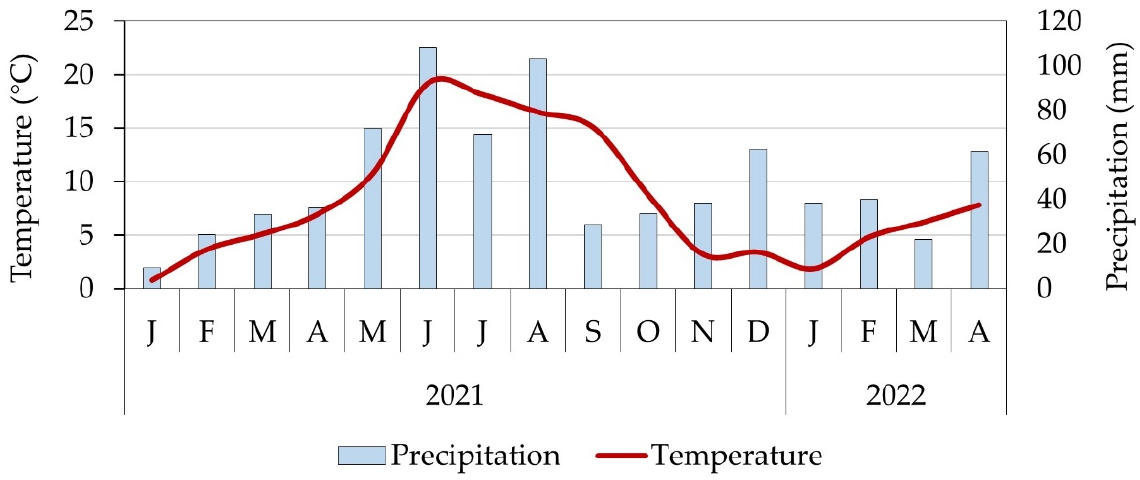
Figure 2. The monthly average temperature and precipitation at the experimental site in Hohen- heim.